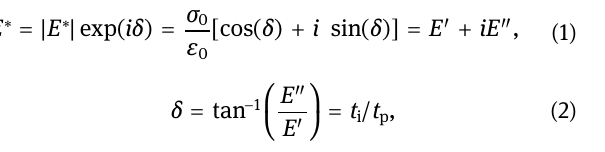
Figure 2: ( a ) DTS - 30 dynamic testing machine and ( b ) specimen and measurement